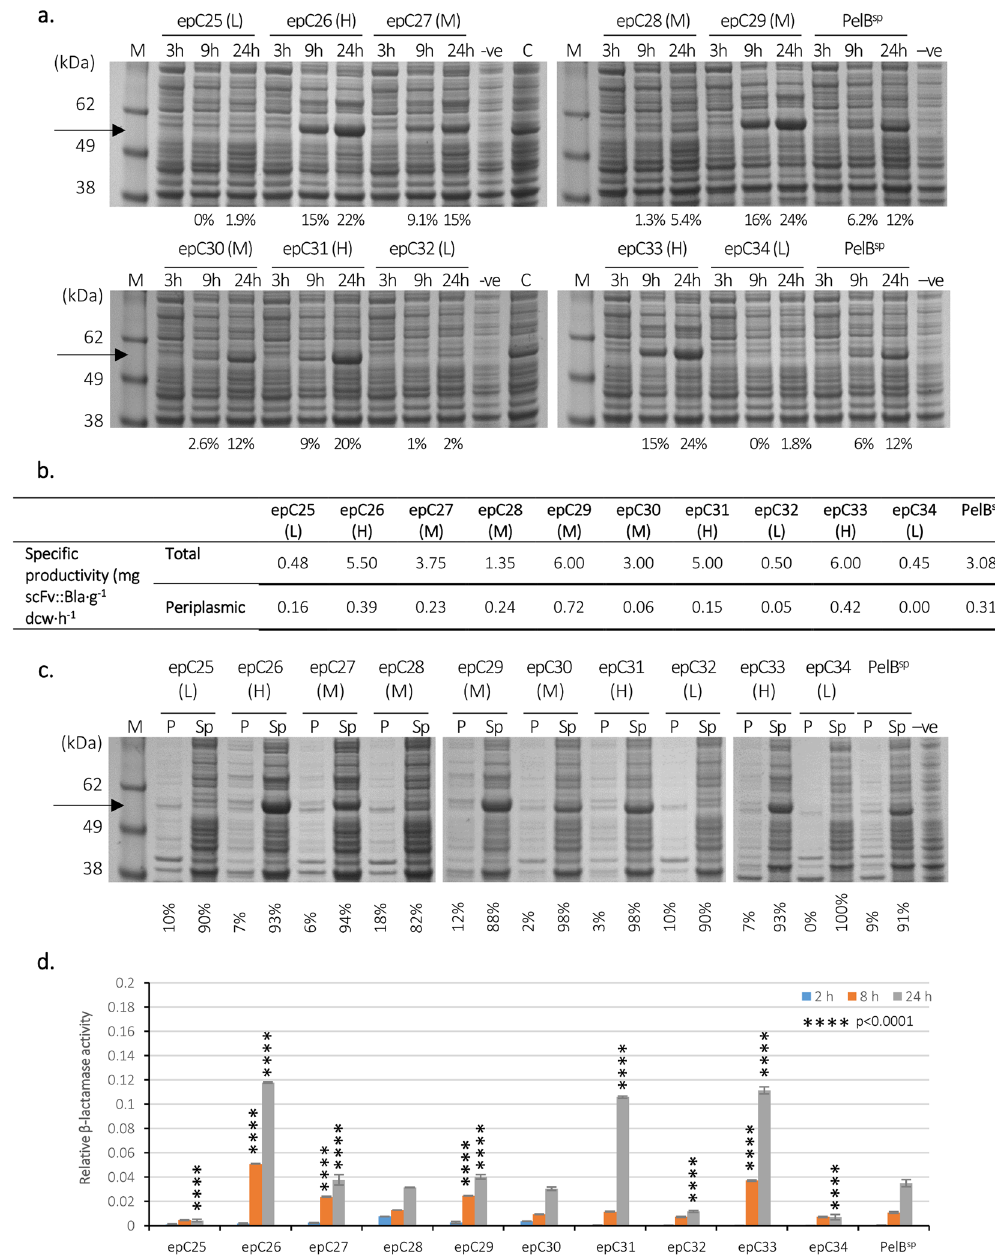
Figure 4. Production of scFv::Bla by clones selected from the epPCR library. E . coli BL21-A carrying vectors coding for different signal peptides from the epPCR library (epC25-epC34) or PelB sp fused to scFv::Bla were grown at 25 °C and induced with 0.02% arabinose at an OD 600 ≈ 0.5. ( a ) SDS-PAGE gels showing accumulation of scFv::Bla (black arrow) from whole cell lysates. Samples were obtained before (3 h) and after induction (9 and 24 hours post-inoculation). M is the molecular size marker. Cultures carrying PelB sp fused to scFv::Bla, the cytoplasmic scFv::Bla (C) or the empty vector (-ve) after 24 hours were used as controls. ( b ) Specific productivity of total scFv and periplasmic scFv at 24 hours growth. Values calculated from densitometry data from panel ( a,c ) as described in supplemental materials and methods. ( c ) The periplasm (P) and spheroplast (Sp) fractions of samples after 9 hours of growth were analysed by SDS-PAGE. The quantity of the scFv::Bla is expressed as percentage of whole cell protein ( a ) and the percentage of protein accumulated in each fraction ( c ). ( d ) The β -lactamase activity of each clone evaluated here. Error bars represent the 5% uncertainty in the calculation of the slopes corresponding to β -lactamase activity (n = 2), which is expressed in terms of change in OD 495 per minute per OD 600 . **** Indicates values statistically significant (P < 0.0001) compared to the control (PelB sp -scFv::Bla) after selecting adjusted p < 0.001 as the level of significance during statistical analysis of data. Uncropped gel images are available in Supplemental Fig.